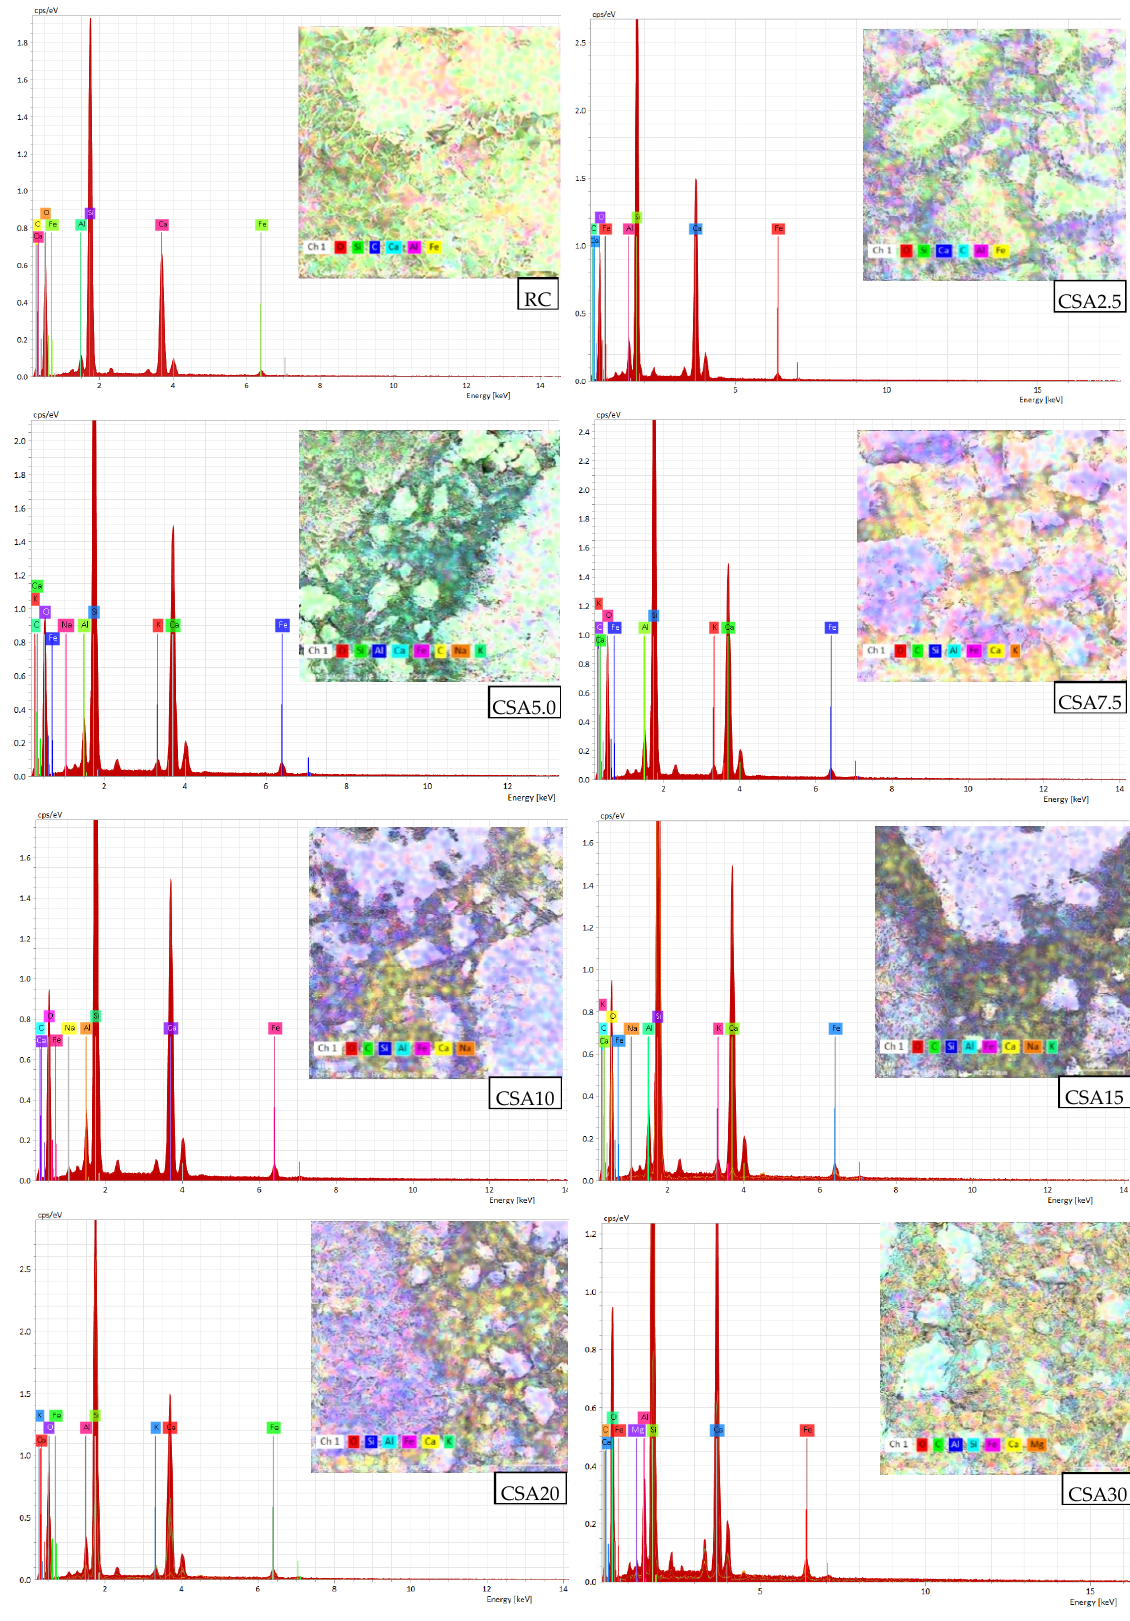
Figure 8. EDS analysis and SEM images at a 400 µm magnification rate of the studied cement-based composites.